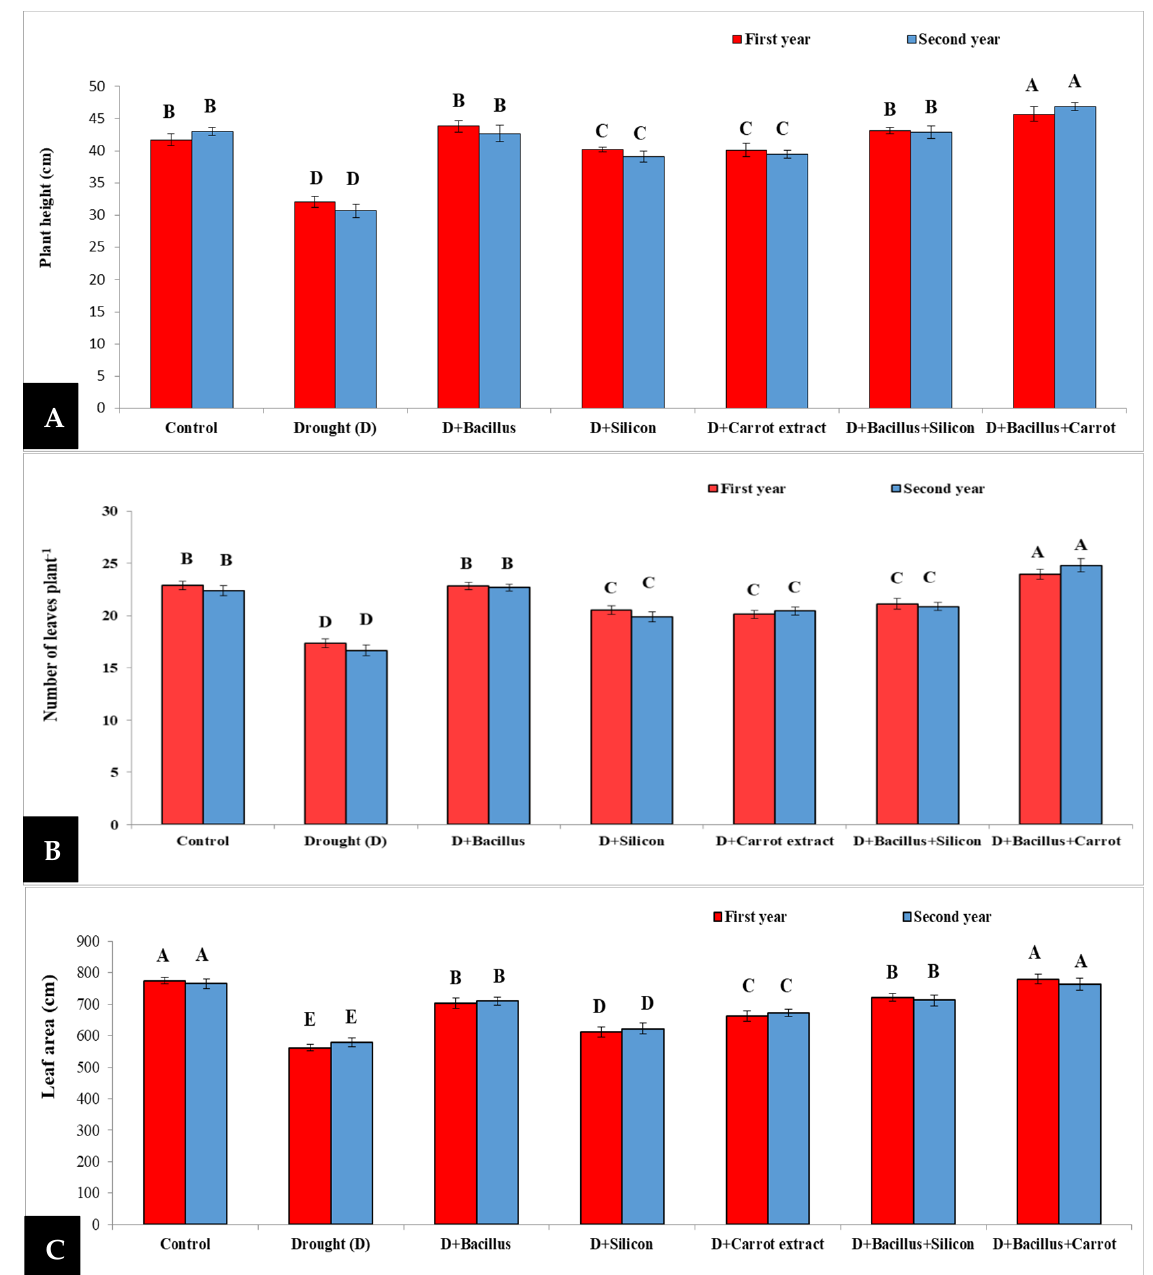
Figure 1. Effect of Bacillus thuringiensis , silicon, and carrot extract on plant height (A), number of leaves (B), and leaf area (C) of drought-stressed pea plants during 2019/2020 and 2020/2021 seasons. Different letters on the columns show significant differences between the treatments according to ANOVA, and Duncan’s post hoc test when the result of the omnibus multivariate F-test in ANOVA was significant ( p ≤ 0.05). Data is the mean (± SE) of five replicates.